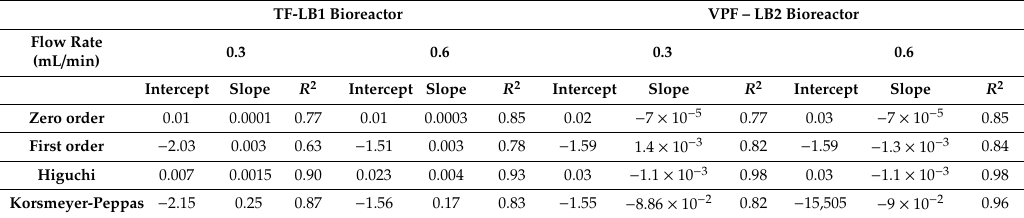
Table 2. Kinetic model elaboration of GS release from electrospun matrices incubated in dynamic conditions in PBS (pH 7.4) at 37 ◦